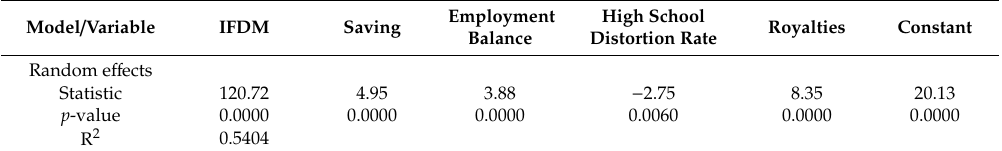
Table 12. Corrected random e ff ects